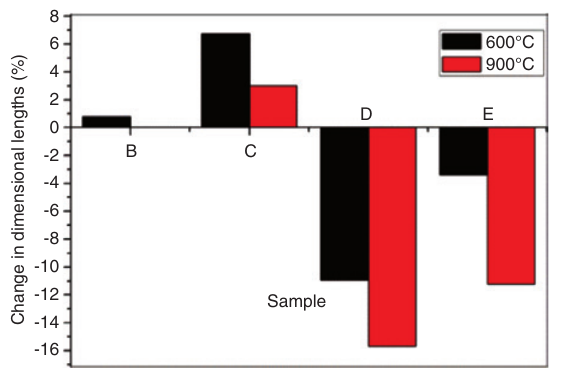
Figure 1: The dimensional changes in terms of shrinkage (-) or expansion that takes place during the conversion of the samples to ceramic after firing in the muffle furnace at 600 and 900 ° C, respectively.